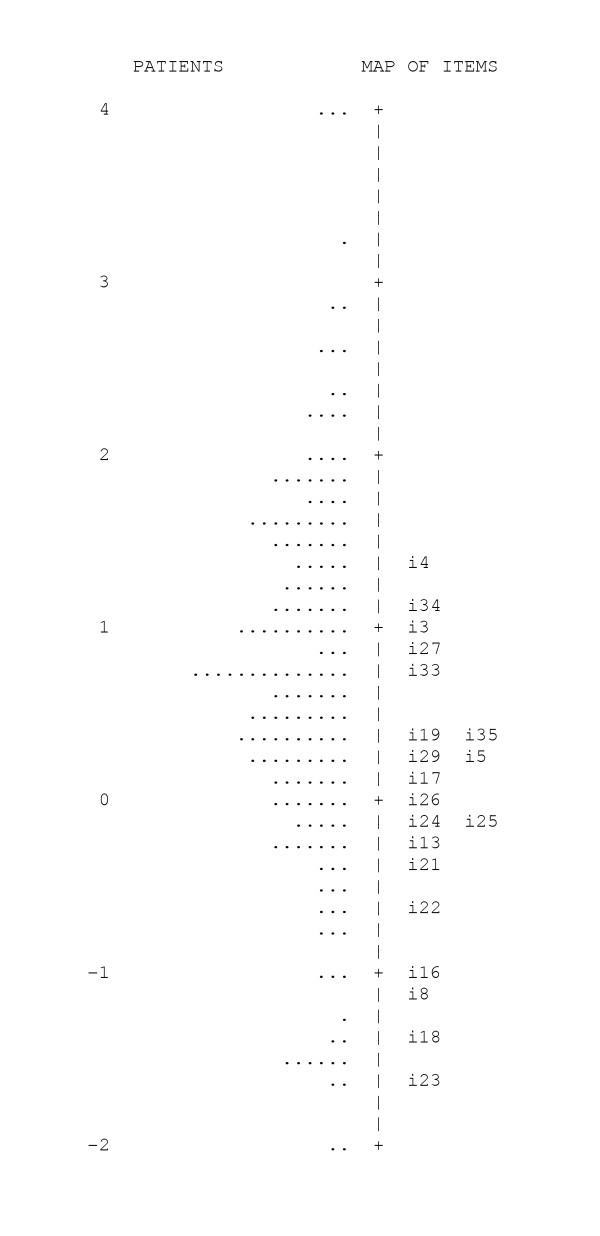
Stoma-QOL Item Calibration of the items located within the spread of the person measures. (logit scores, the measurement unit common to both patients and items, are displayed down the middle of the map; patient, represented by a single dot, are arranged within the scale from better (top) to worse (down) quality of life; items are identified by the item number)